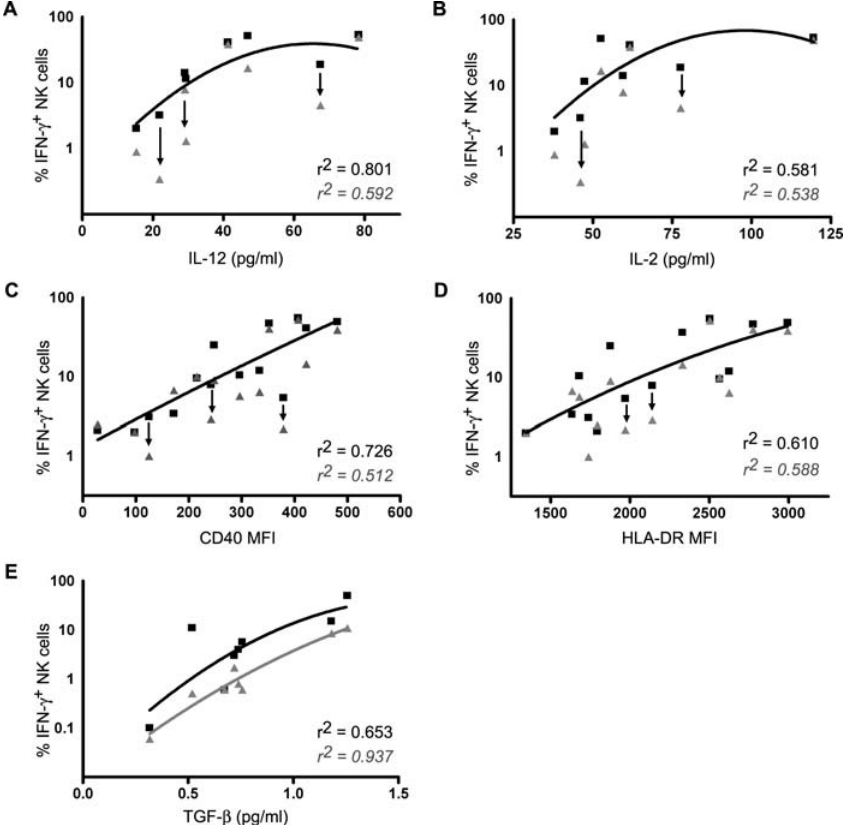
Figure 8. NK Cell IFN- c Response to iRBCs Correlates with Accessory Cell Activation NK cell IFN- c responses in PBMCs from eight malaria-naı¨ve donors were analysed after 24 h of co-culture with iRBCs. The concentration in tissue culture supernatants of IL-12p70 and IL-2 was determined in a bead-based cytokine assay, and that of bioactive TGF- b by ELISA. The fluorescence intensities of CD40 and HLA-DR surface staining on CD14 þ monocytes and the percentage of IFN- c þ CD56 þ NK cells were determined by flow cytometric analysis. Shown are the percentages of IFN- c þ CD56 bright NK cells (black squares) and IFN- c þ CD56 dim NK cells (grey triangles), along with the correlation of the percentage of IFN- c þ CD56 bright NK cells (black line) with the concentration of IL-12p70 and IL-2 in culture supernatants (A and B), with the MFI of CD40 and HLA-DR on resting monocytes (C and D), and with the up-regulation of bioactive TGF- b in culture supernatants (E). The correlation of TGF- b in culture supernatants with IFN- c þ CD56 dim NK cells is also shown (E, grey line). Correlation coefficients are indicated for CD56 bright (upper values) and CD56 dim (lower values). Correlations were calculated using a second-order polynomial fit algorithm. Black arrows indicate examples of donors where IFN- c response is highly suppressed in the CD56 dim NK cells. Flow cytometric data are based on the collection of 100,000 total events.